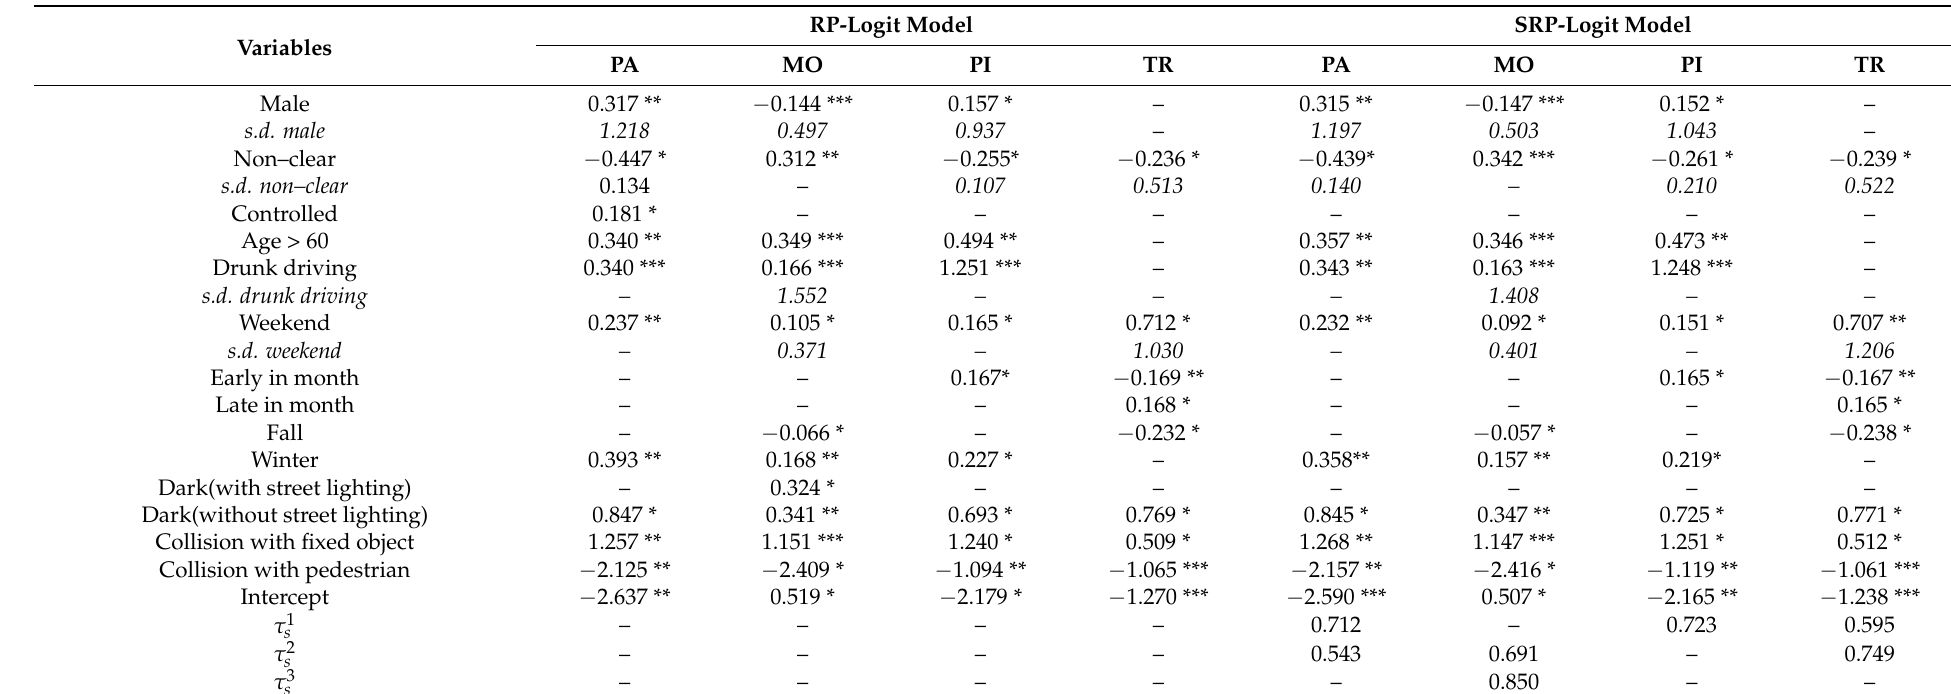
Table 5. Estimation of the parameters of the RP-logit model and the SRP-logit